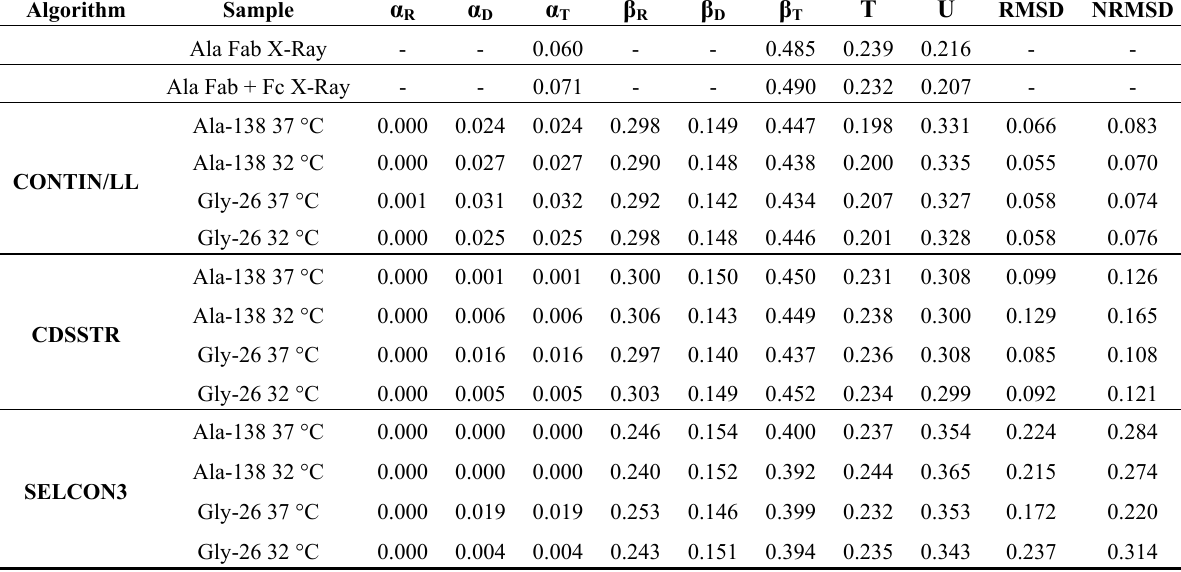
Table 2. Secondary structure estimation from CD data using the CDPro software